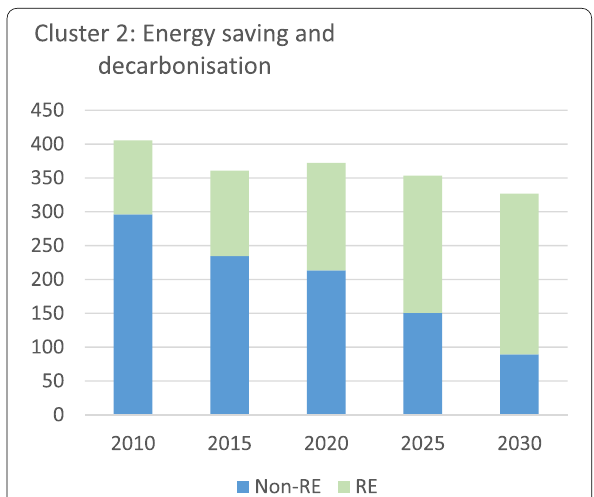
Fig. 5 Total consumption of energy between 2010 and 2030 in ‘energy saving and decarbonisation’ scenario (N.B. the total consumption was 378 TWh in 2019; 2010 and 2015 have been added [35])